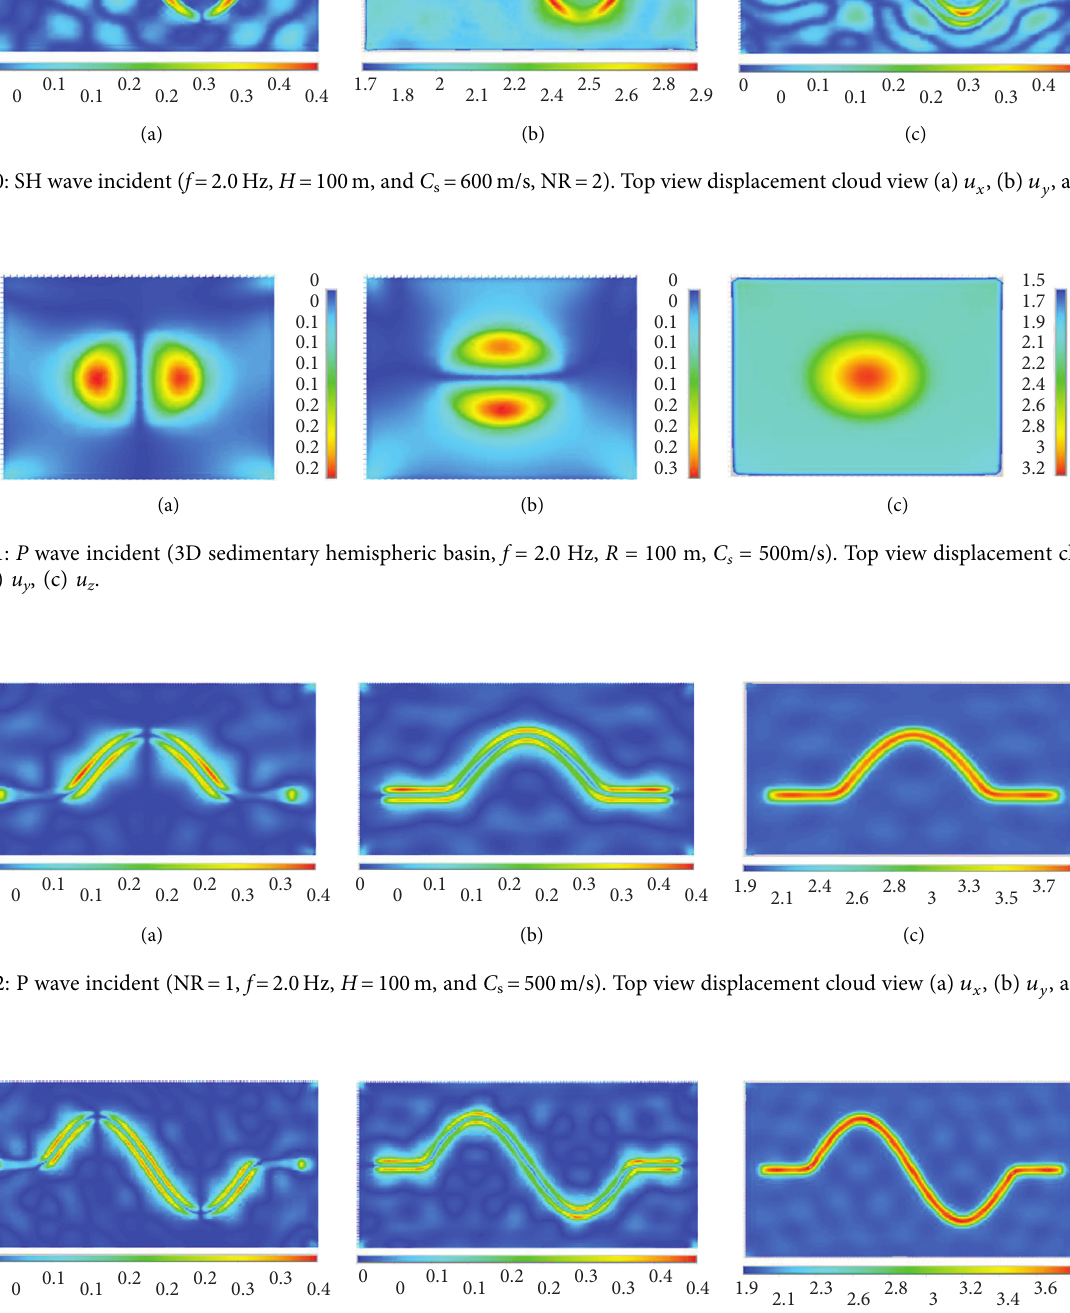
� 500m/s). Top view displacement cloud view (a) u s